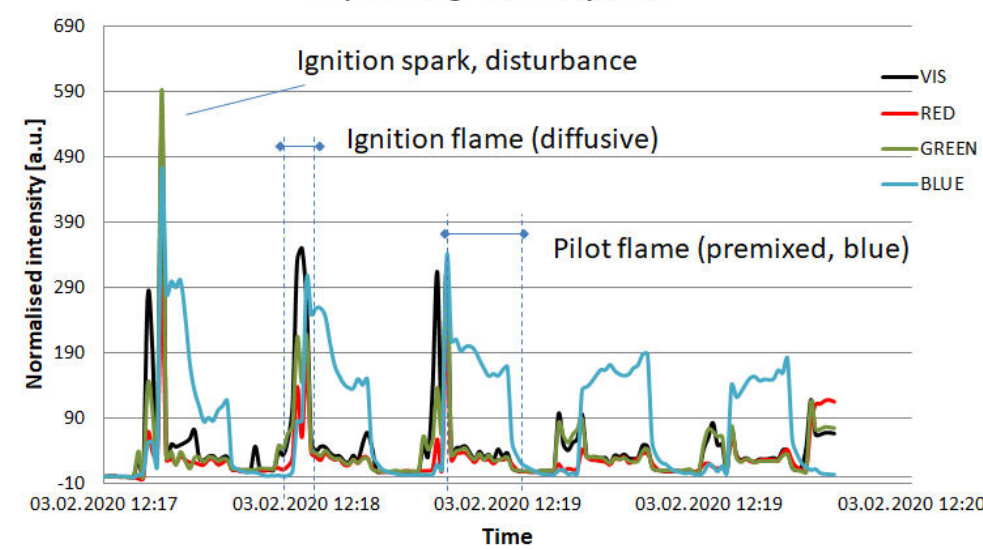
Figure 20. Ignition sequence under pressure, including the start of the ignition flame, then activation of the pilot flame followed by the stoppage of the ignition flame, and eventually turning off of the pilot flame.